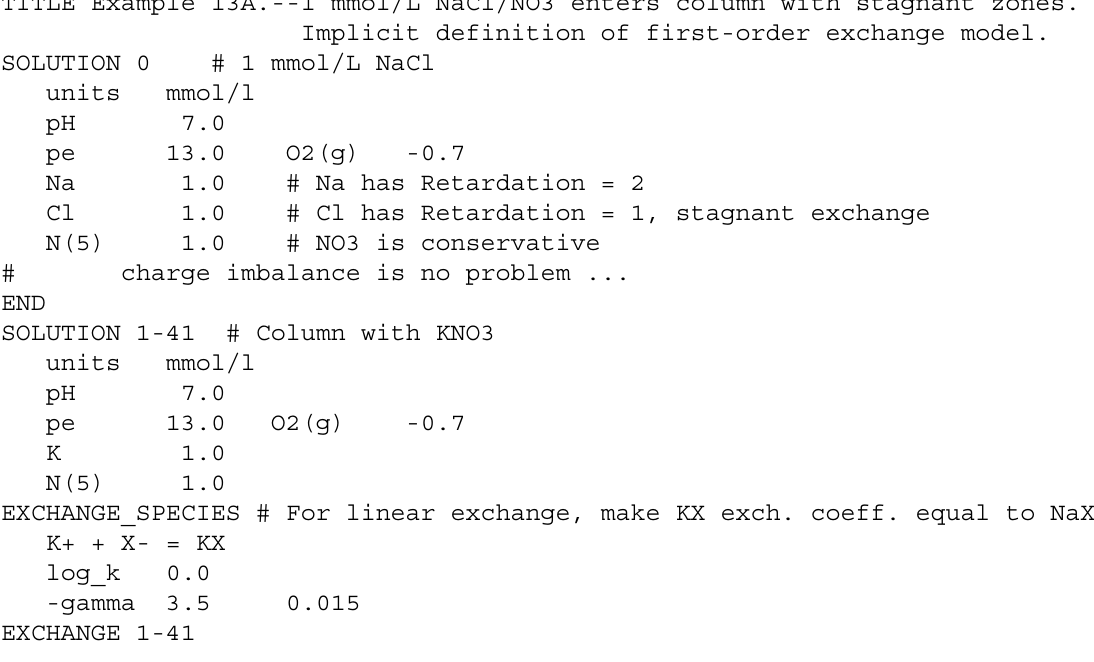
Table 33. Input file for example 13A: Stagnant zone with implicitly defined mixing factors. TITLE Example 13A.--1 mmol/L NaCl/NO3 enters column with stagnant zones. Implicit definition of first-order exchange